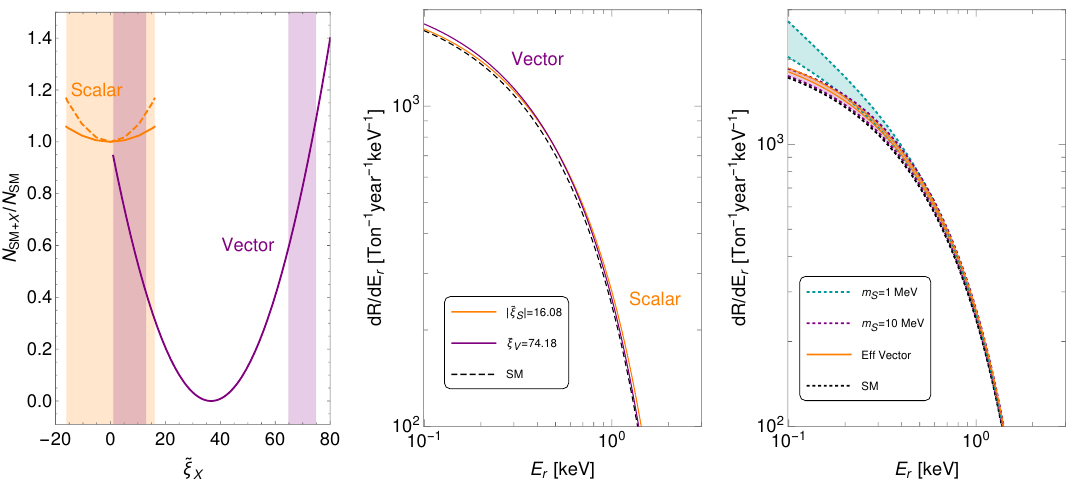
Figure 4 . Left graph : expected number of events in the presence of vector and scalar e(cid:11)ective interactions ( m X & 10 3 MeV) normalized to the SM expectation as a function of the e(cid:11)ective parameter e (cid:24) X ( X = V; S ). The calculation is done assuming a 10 (cid:0) 1 keV threshold, a 1 ton- year exposure, 100% detector e(cid:14)ciency and xenon as target material. Included as well is the result for scalar interactions obtained by taking a 1 keV threshold (dashed orange curve). The shadowed stripes indicate the 90% CL limits from COHERENT data. Middle graph : recoil spectra of R N SM+X =N SM (1 : 0 ; 1 : 05]. This result demonstrates that measurements of R (cid:17) (cid:26)